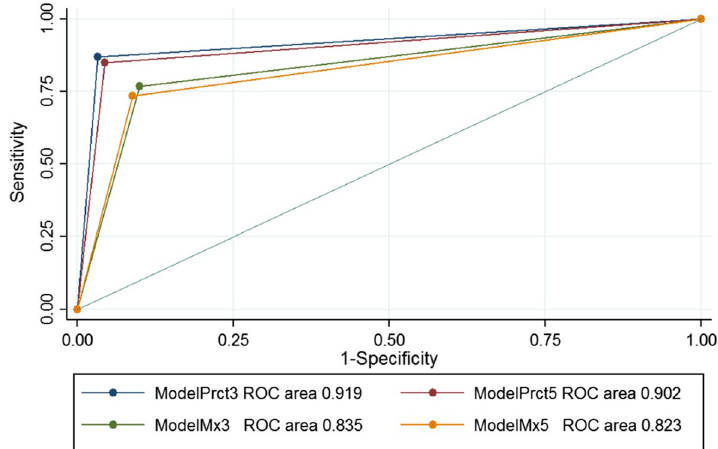
Fig. 2 Pulmonary embolism ROC curve in the training